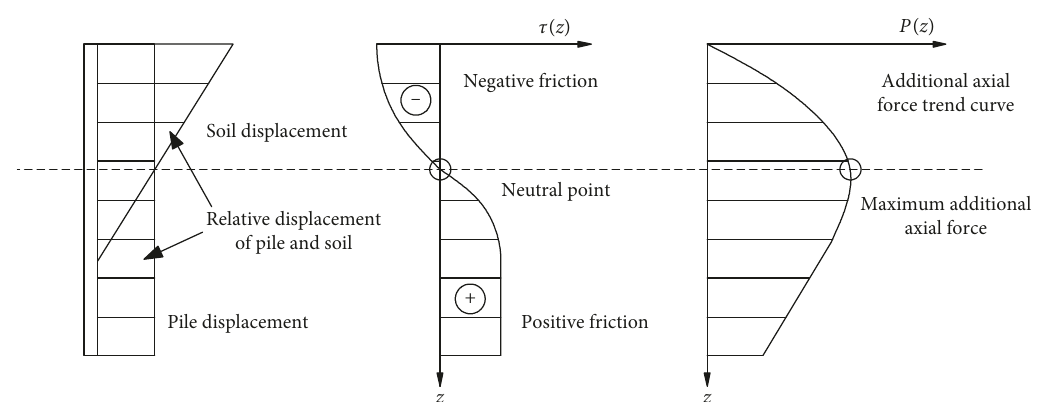
Figure 7: Diagrams of relative displacement, negative and positive friction, and axial force.